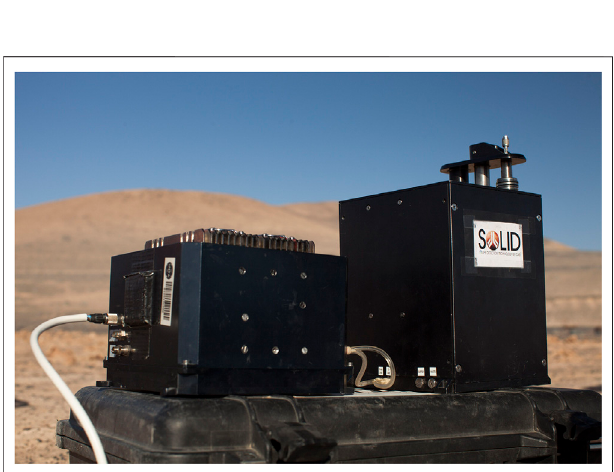
FIGURE 5 | SOLID, the Signs of Life Detector, developed a the Centro de Astrobiology (Center of Astrobiology) in Spain. Photo credit: Victor